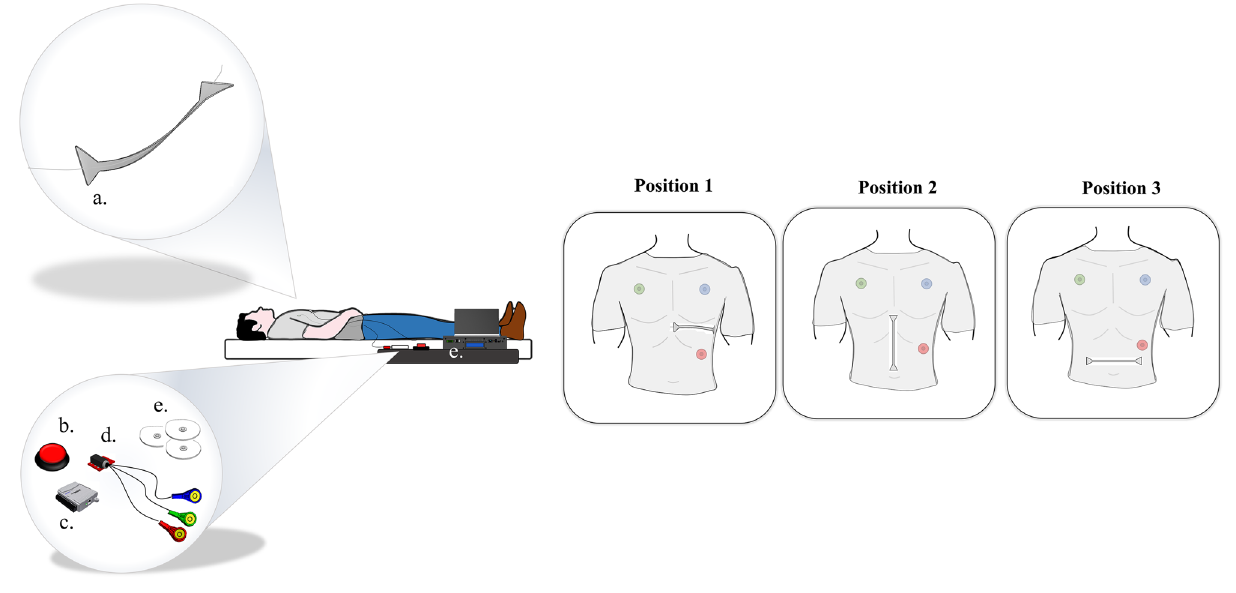
Figure 3. The experimental setup during the test procedure. The SWS ( a ) taped on the T-shirt, the push button for the signal synchronization ( b ), the DAQ ( c ) used to collect the ECG trace and the trigger signal, the ECG sensor ( d ) and the FBG interrogator ( e ).